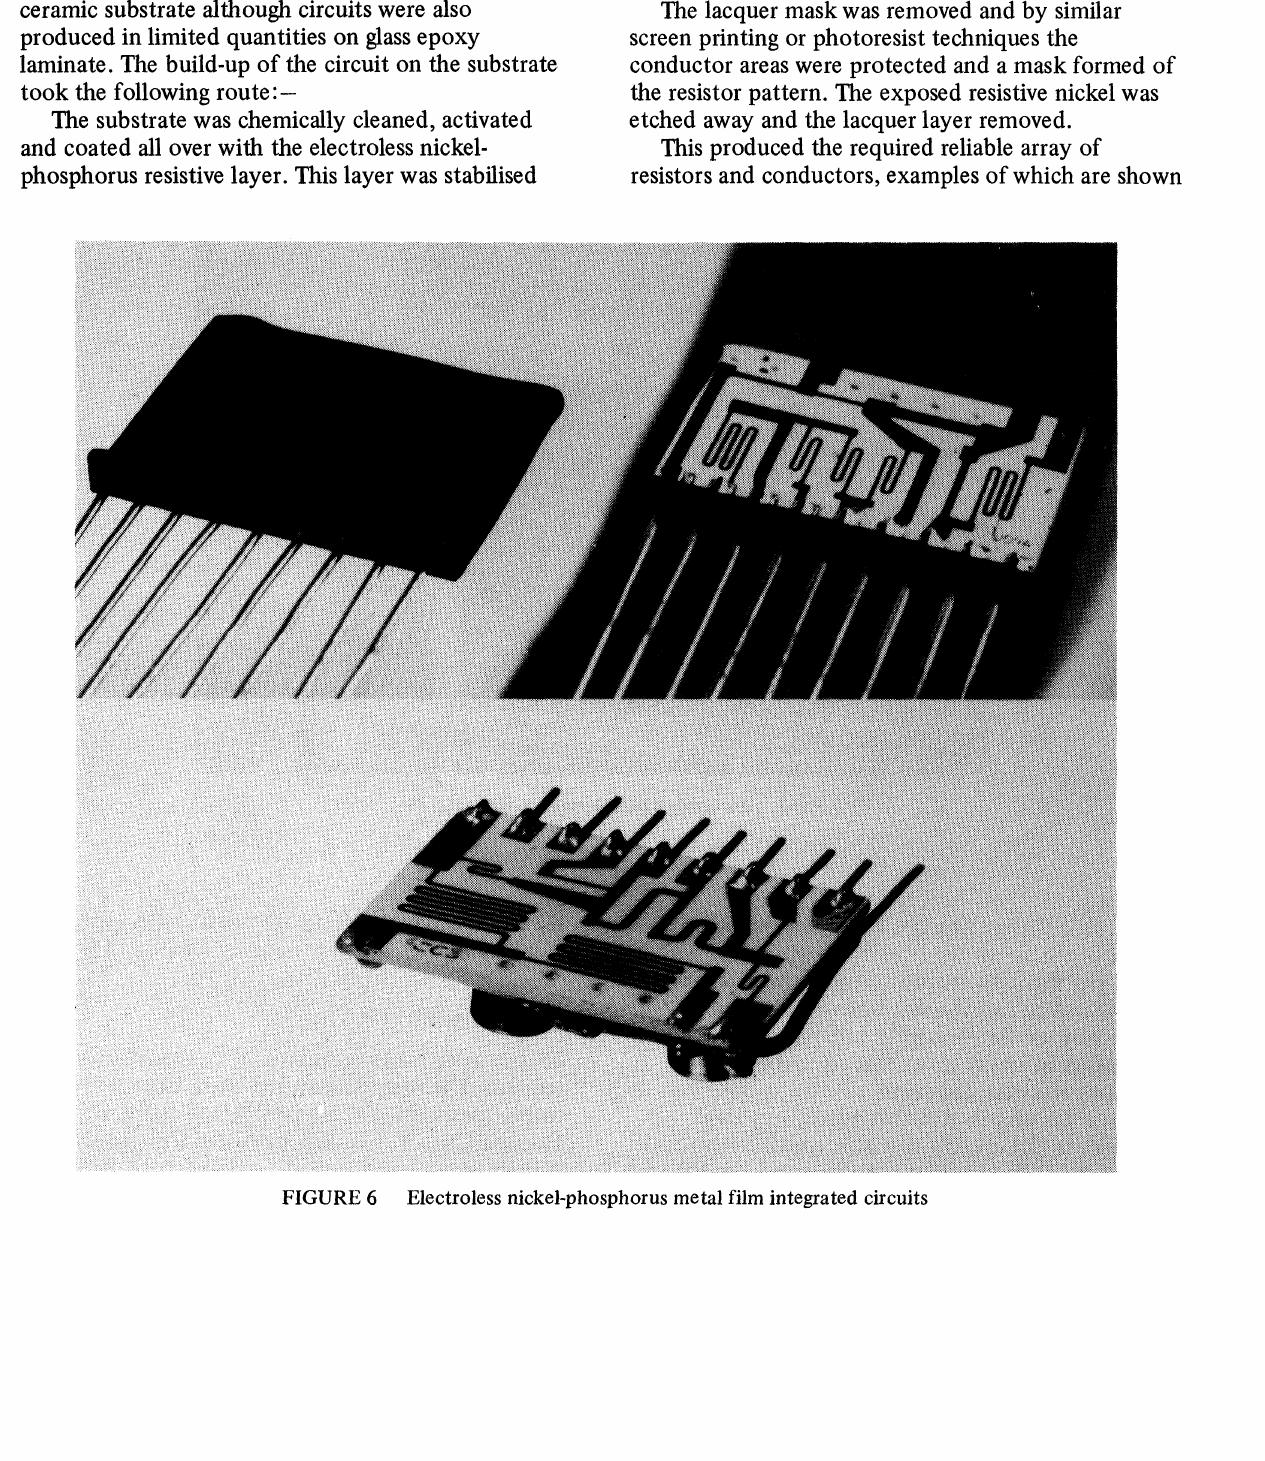
FIGURE 6 Electroless nickel-phosphorus metal film integrated